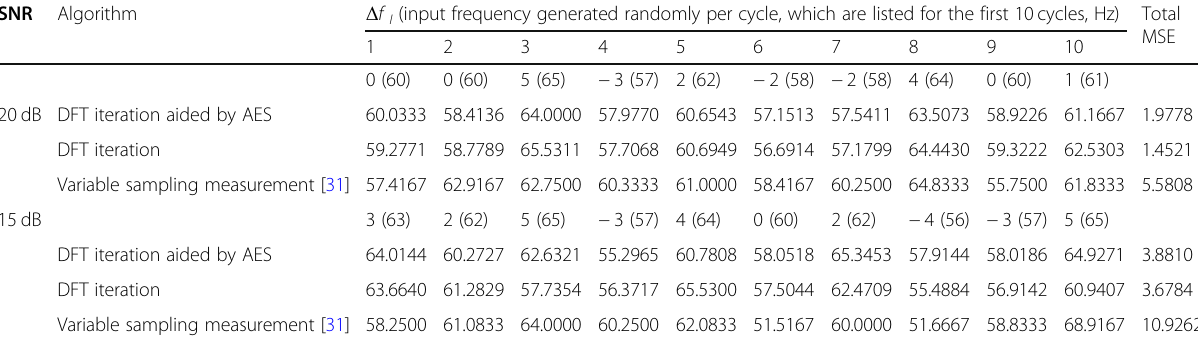
Table 2 Comparison of three algorithms (iterative process stops at third iteration) SNR